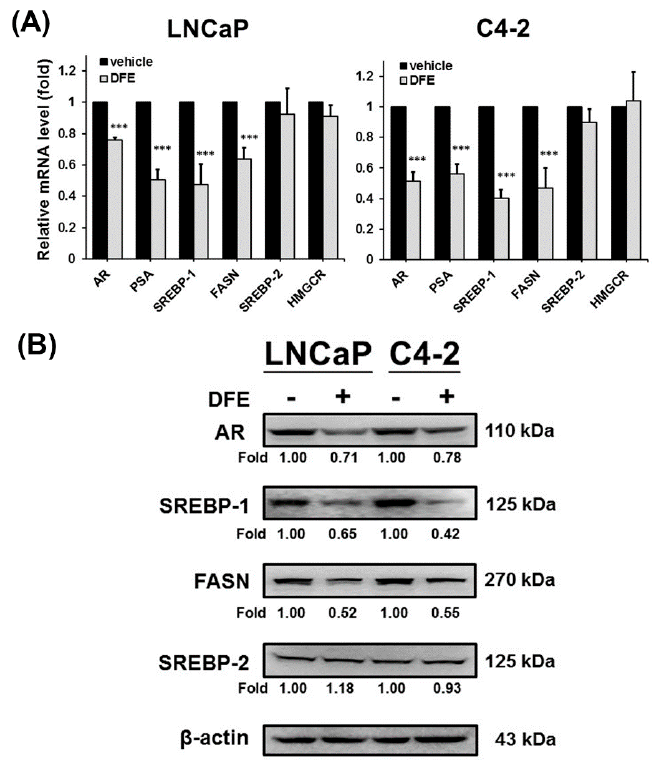
Figure 3. DFE inhibited sterol regulatory element-binding protein-1 (SREBP-1) / fatty acid synthase (FASN) and androgen receptor (AR) / prostate-specific antigen (PSA) expression in LNCaP and C4-2 cells. ( A ) DFE inhibited the messenger RNA (mRNA) expression of AR / PSA and SREBP-1 / FASN, but did not significantly a ff ect SREBP-2 and 3-hydroxy-3-methyl-glutaryl-coenzyme A reductase (HMGCR) mRNA expression in PCa cells. The relative mRNA level was defined as 1.0 (fold) in the vehicle-treated cells. Data were normalized by β -actin mRNA expression and shown as the mean ± SD of triplicate assays with three independent experiments. *** p < 0.001. ( B ) DFE reduced the protein amounts of AR, SREBP-1, and FASN in LNCaP and C4-2 cells. β -actin was used as a loading control. Data were normalized by β -actin protein expression. The relative fold was defined as 1.00 in the vehicle-treated LNCaP or C4-2 cells,